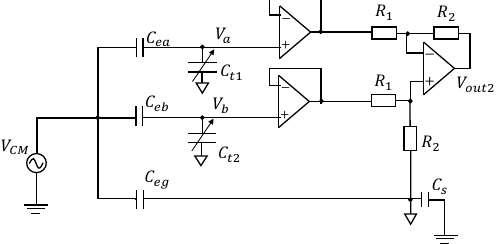
Figure 3. CM equivalent circuit of “DTC Bypath”.